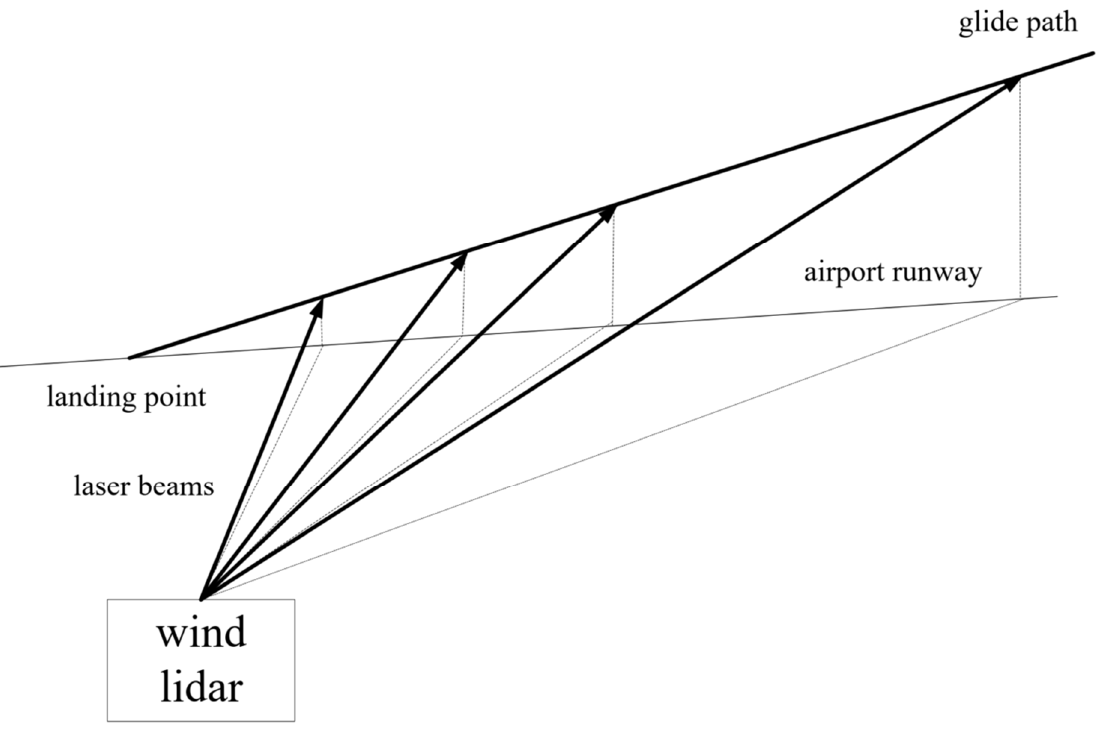
Figure 1. Schematic diagram of glide path scanning.